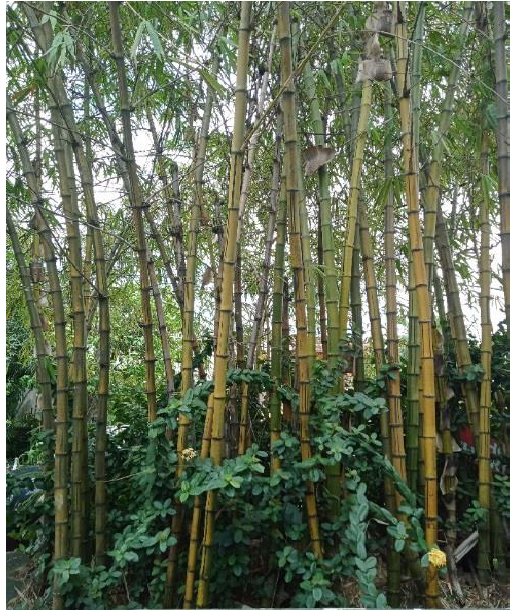
Figure 1. Bamboo tree.